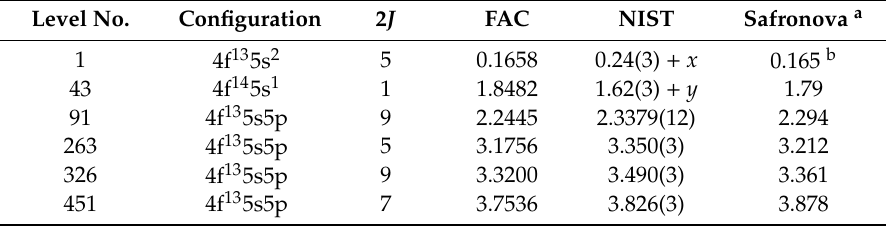
Table 11. Comparison of energy levels (in Rydberg) calculated with FAC for Pm-like W with other available results. Level No.